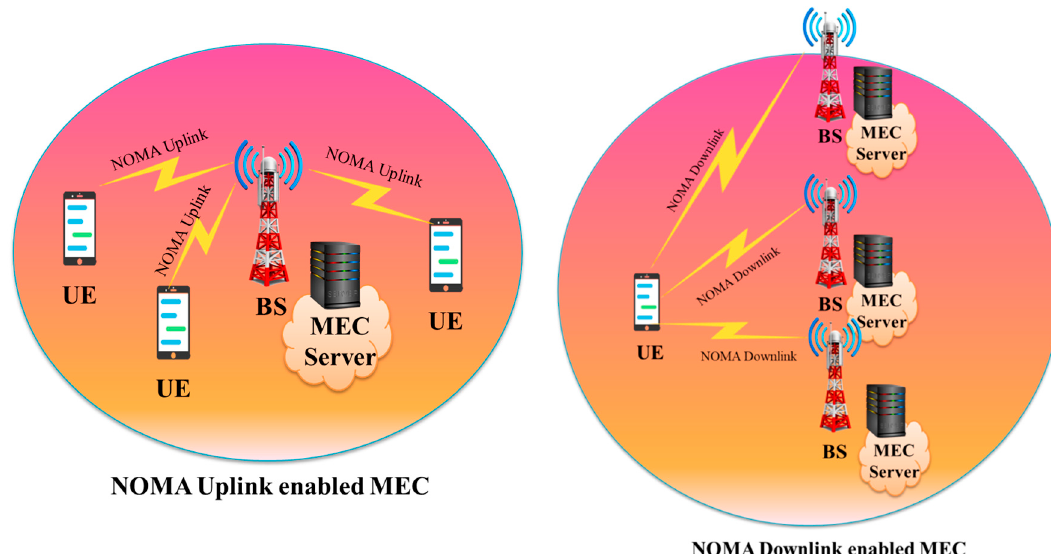
Figure 9. NOMA-MEC scenario for uplink and downlink. Table 4. Summary of studies on MEC scenario